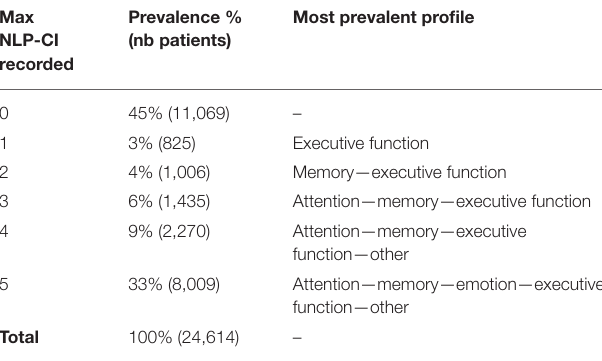
TABLE 2 | Cognitive impairments profiles (Sample